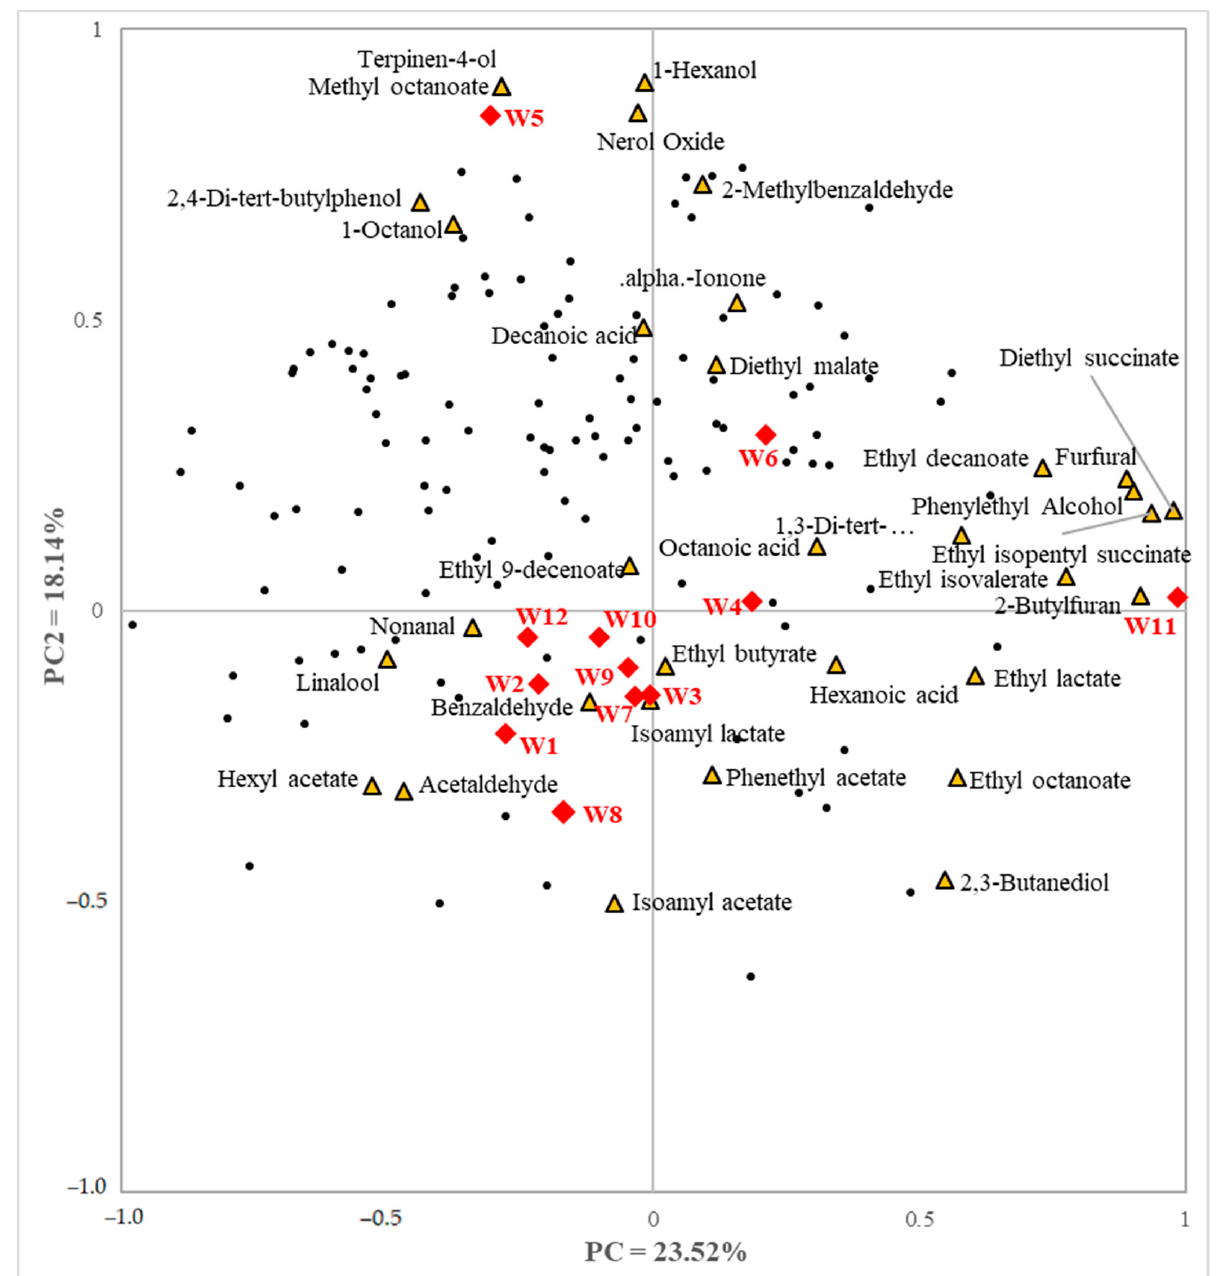
Figure 4. Internal preference map using consumers’ overall preference scores and volatile compounds. The yellow triangles indicate the volatile compounds, red diamonds indicate the white wine samples, and black dots indicate individual consumer preference.